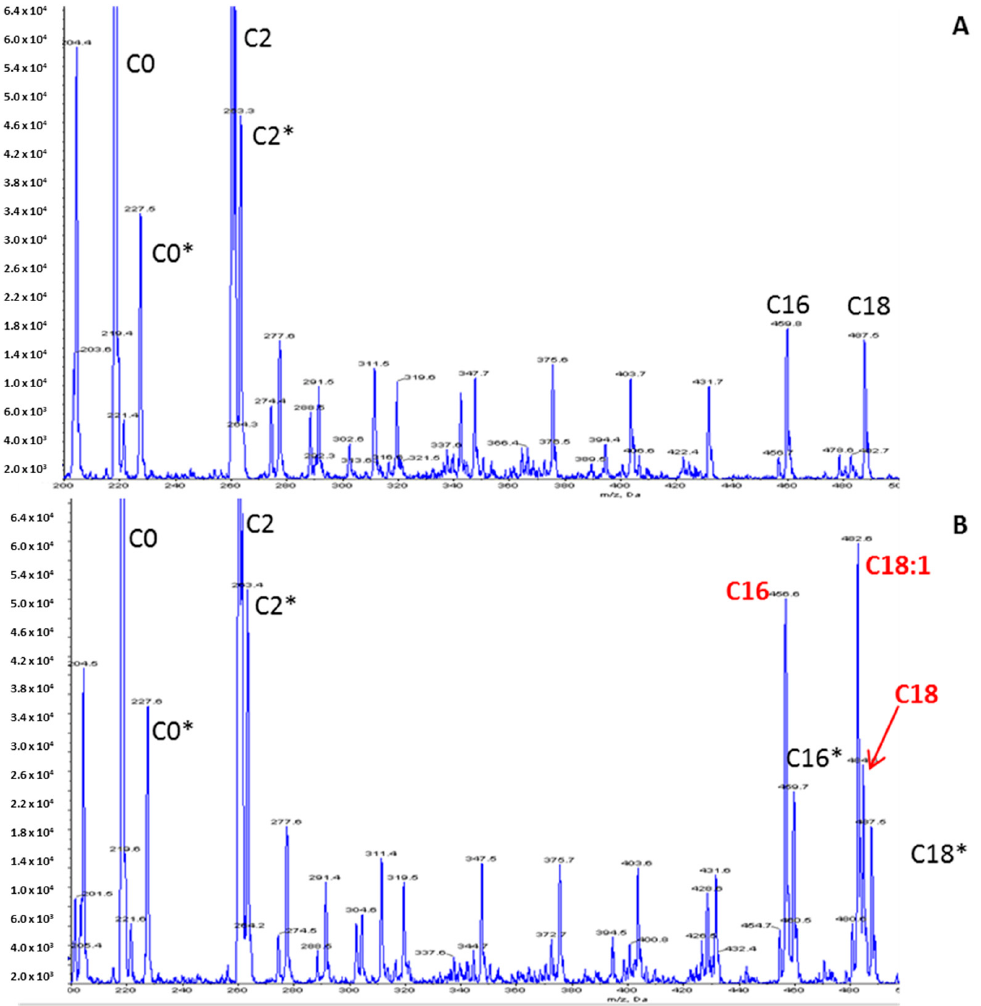
Figure 2. Acylcarnitine profile using an LC-MS/MS method. ( A ) Control; ( B ) Patient. Peaks represent butylated esters of acylcarnitines acquired by precursor ion scanning of 85 m / z in positive ion mode. Derivatized samples were injected into a Sciex 4000 QTRAP mass spectrometer (Sciex, Framingham, MA, USA) using an autosampler. Peaks corresponding to isotopically labeled internal standards are denoted by an asterisk.